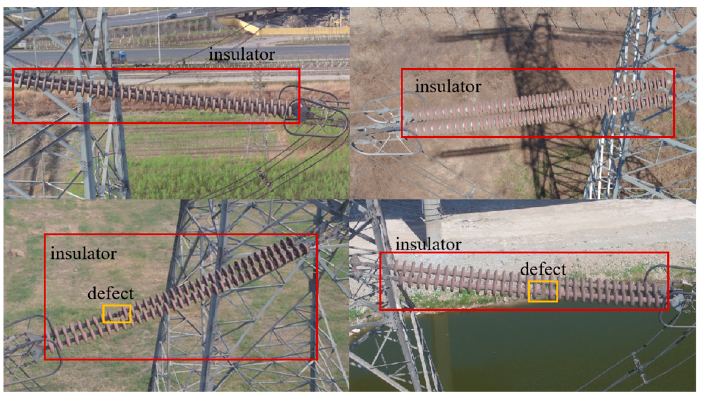
Figure 9. Insulator and defect images.